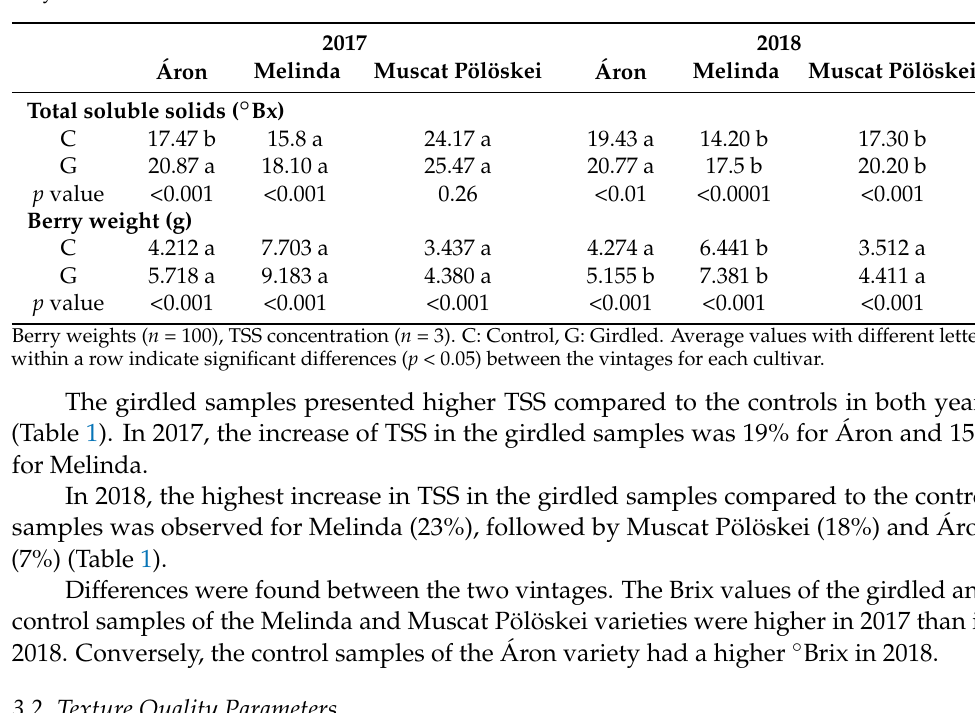
Table 1. Berry fresh weights and total soluble solids (TSS, ◦ Bx) of the grape juices in the experimen- tal